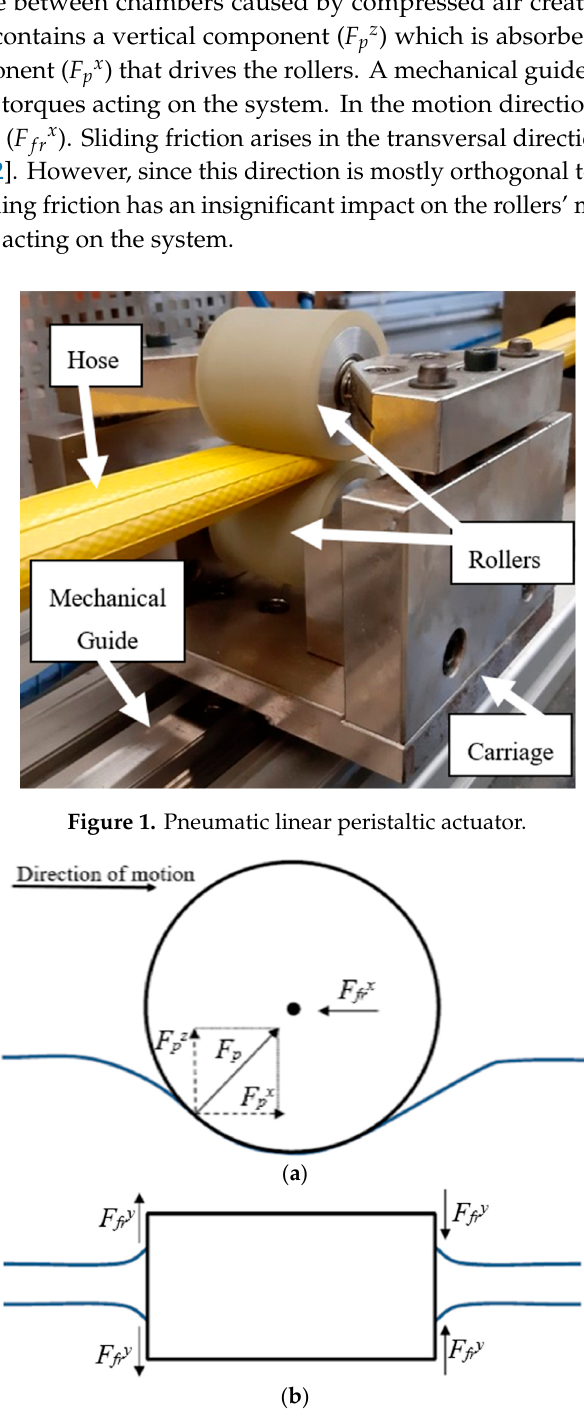
Figure 2. Forces acting in the pneumatic linear peristaltic actuator (PLPA): ( a ) lateral view and ( b ) top view.